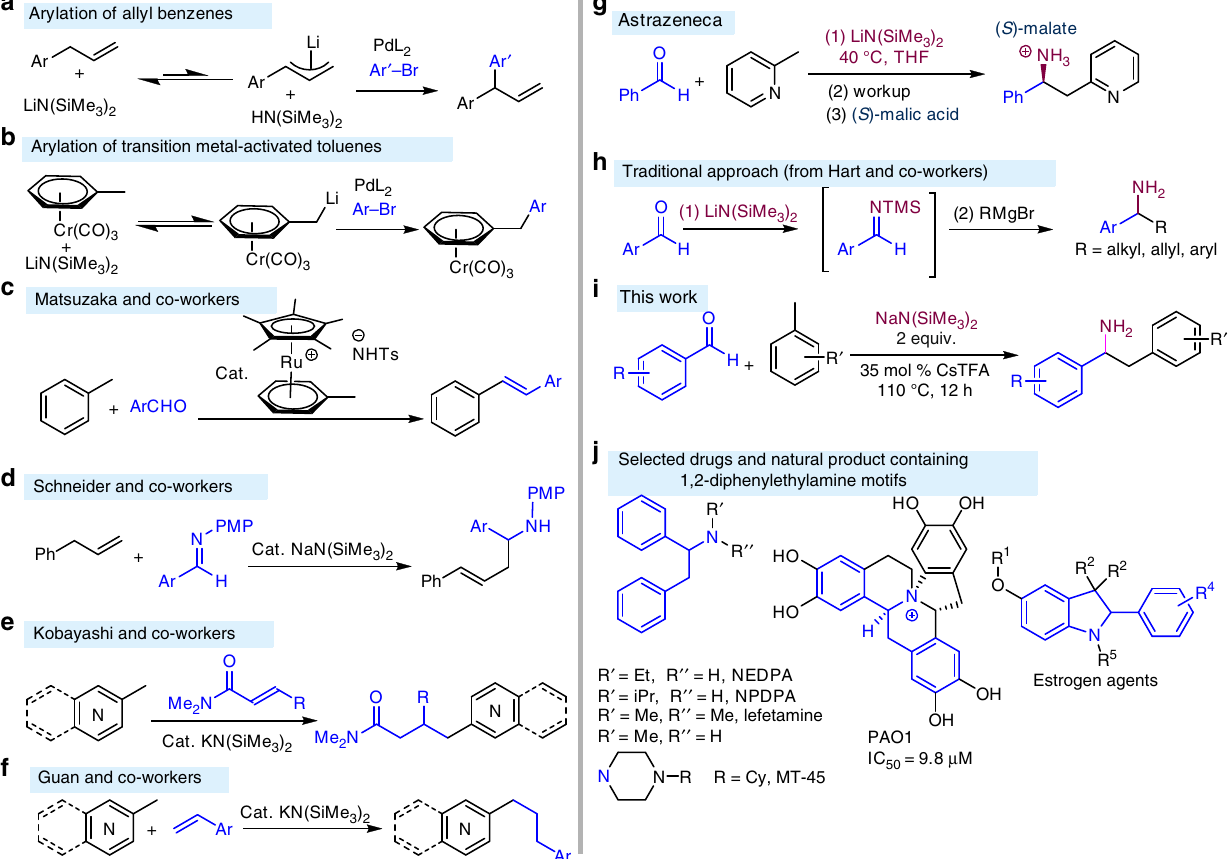
Fig. 2 Benzylic deprotonation and related chemistry. a Arylation of allyl benzene. b Arylation of transition metal-activated toluene derivatives, c catalytic arene activation with a ruthenium complex. d Catalytic deprotonation of allyl benzene and imine addition. e Catalytic 1,4-addition reaction with alkylazaarenes by Kobayshi and co-workers. f Catalytic addition of benzylic C – Hs to styrenes by Guan and co-workers. g Related chemistry with more acidic 2-methyl pyridine. h Traditional approach from Hart and co-workers. i Aminobenzylation of aldehydes (this work). j 1,2-Diphenylethylamine-based drugs and natural